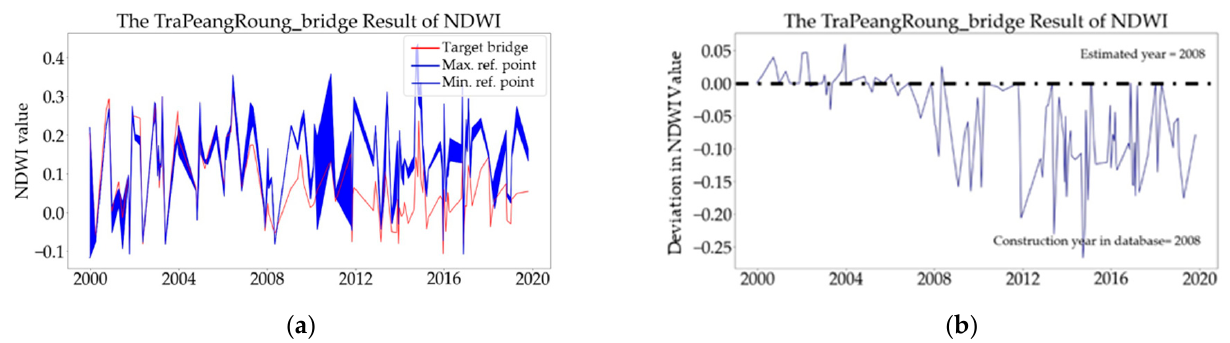
Figure 14. ( a ) Deviation of NDWI value from reference points (blue shaded region) for the Tra Peang Roung bridge; ( b ) re-visualization of ( a ) showing the NDWI difference, showing that it was constructed in 2008.